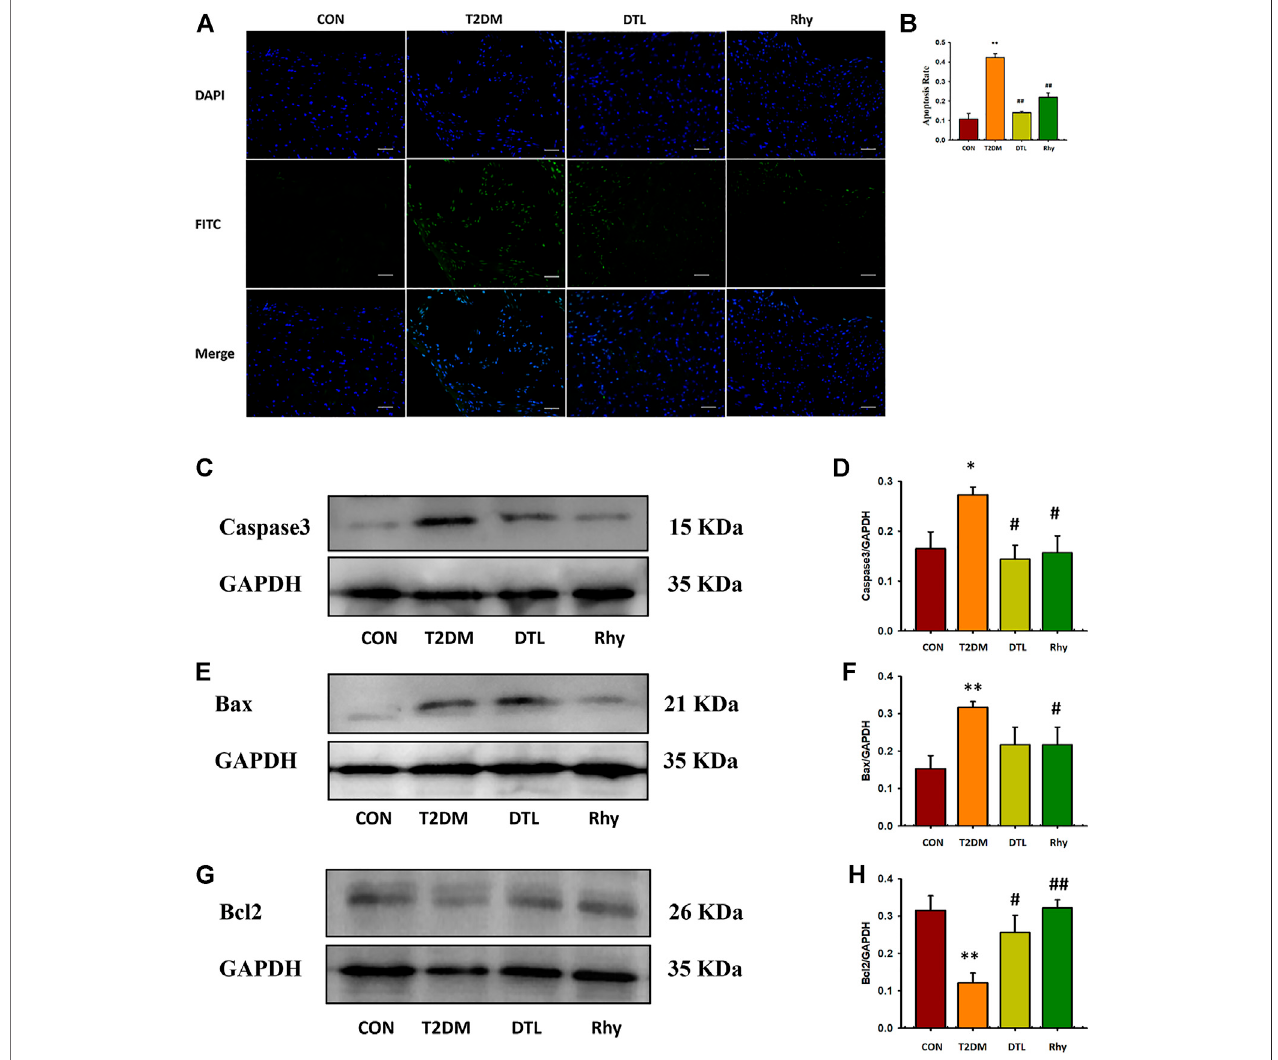
FIGURE 6 | Effect of rhynchophylline on the degree of apoptosis in cardiac tissue. (A) Representative sections of apoptosis in cardiac tissues of each group (magni fi cation, ×200). (B) The degree of apoptosis in cardiac tissue. (C – H) Caspase-3, Bax, and Bcl-2 protein expressions in heart tissue were determined by western blot analysis. Relative intensities of caspase-3 (D) , Bax (F) , and Bcl-2 (H) were calculated by normalization to glyceraldehyde-3-phosphate dehydrogenase in each group;Valuesarepresentedasmean±standarderrorofthemean.* p < 0.05,** p < 0.01vs.controlgroup;# p < 0.05,## p < 0.01vs.type2diabetesmellitusgroup ( n = 3, 1-way analysis of variance, Holm – Sidak post-hoc